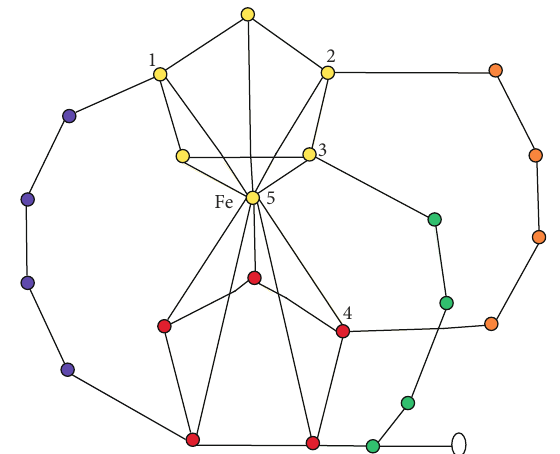
Figure 2: Subdivision of K